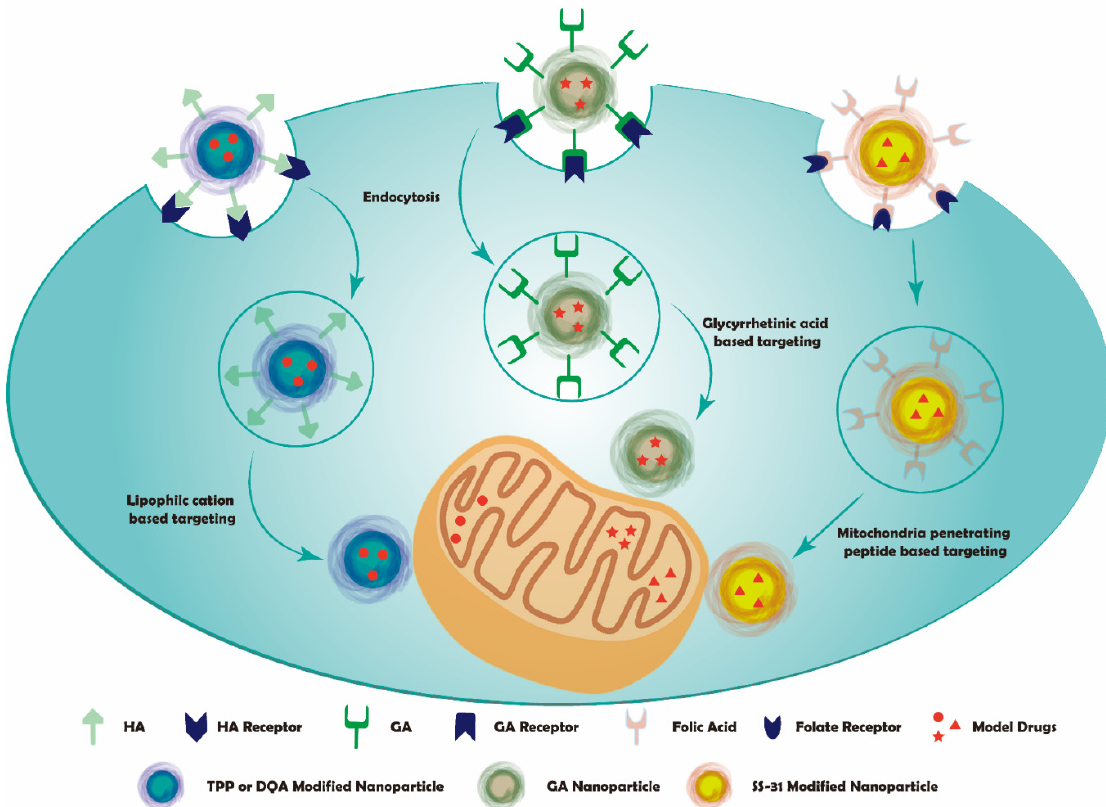
Figure 2. Schematic representation of sequential mitochondria targeting. Therefore, lipophilic cations can be used as mitochondria targeting moiety in mito- chondria targeting drug delivery systems. For example, triphenylphosphonium (TPP) cations, dequalinium (DQA), rhodamine, cyanine cations, quaternary ammonium salts, pyridinium, and berberine cations